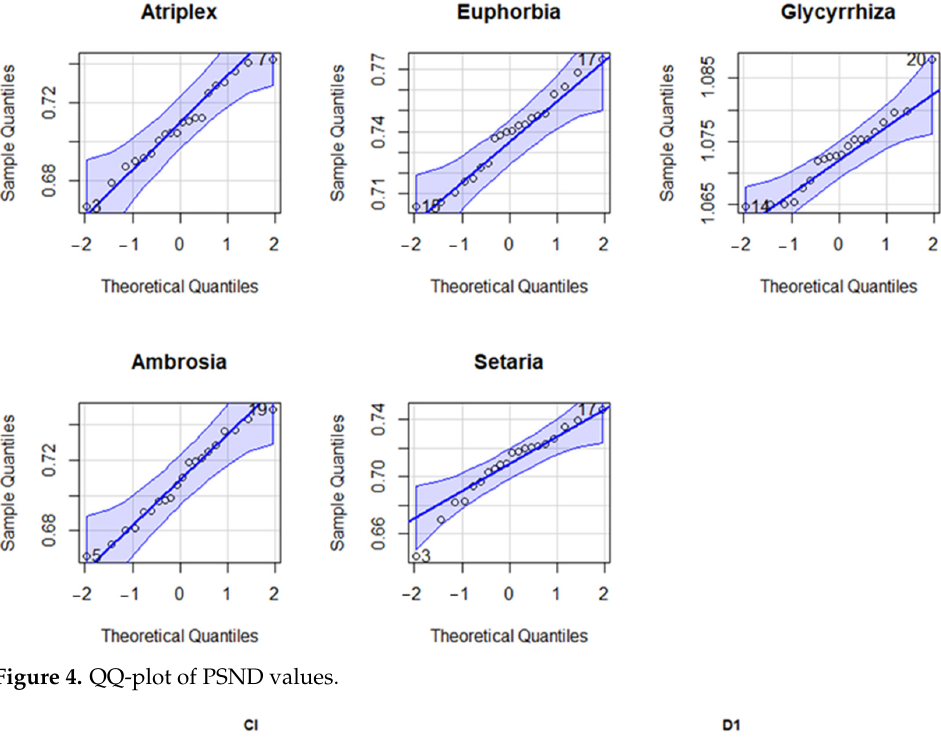
Figure 4. QQ-plot of PSND values.